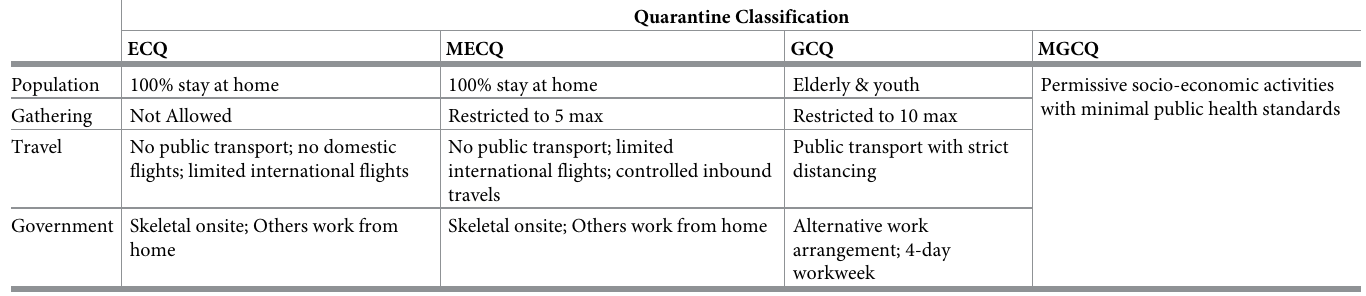
Table 1. Quarantine classification, sample restrictions, Davao City, Philippines